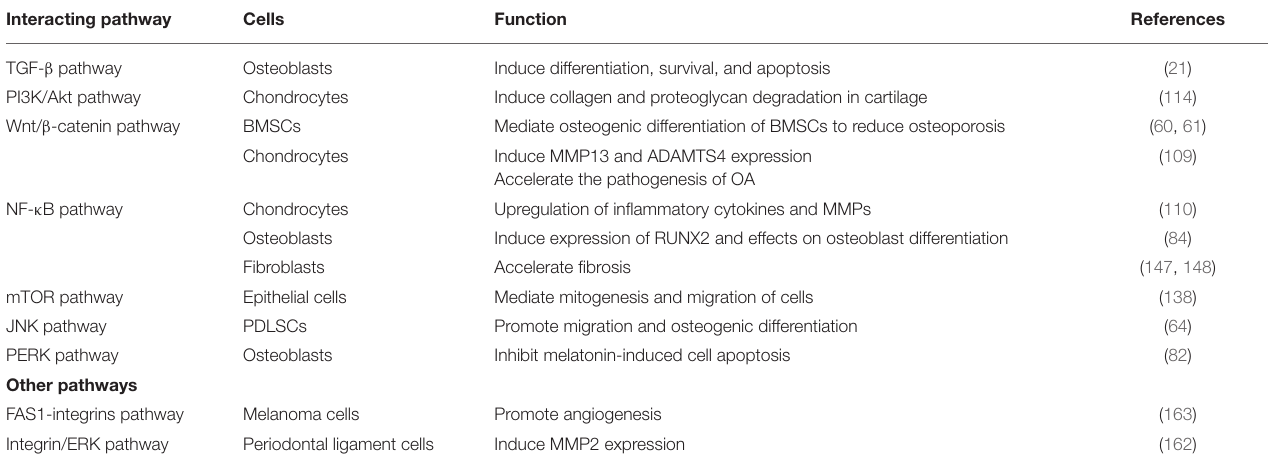
TABLE 2 | Periostin and its interacting signaling